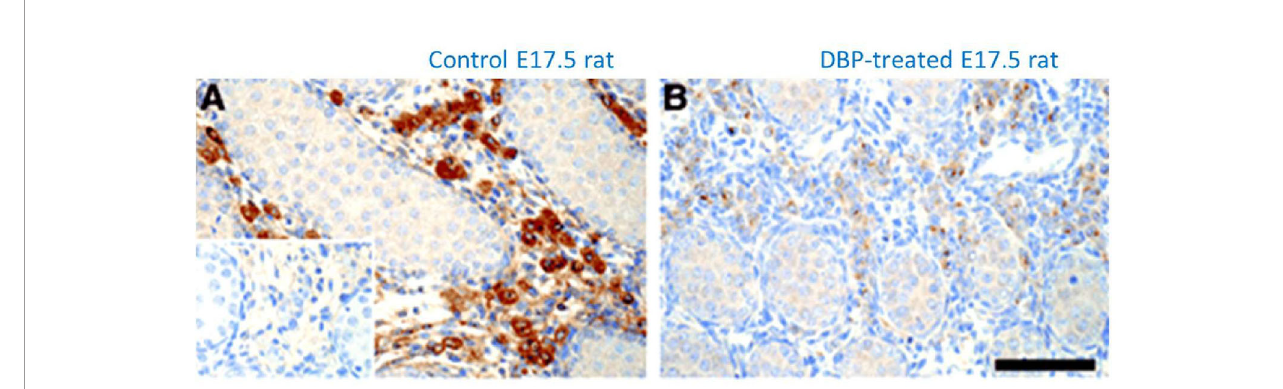
FIGURE 4 | Immunohistochemical staining for INSL3 (brown color) in the fetal testes on gestational day E17.5 of male rats which had been maternally exposed to dibutyl phthalate (B ; DBP ) or vehicle (A) during the important window for male development (E12-E16). Control section using pre-immune serum is indicated in the bottom left of panel (A) [reproduced from